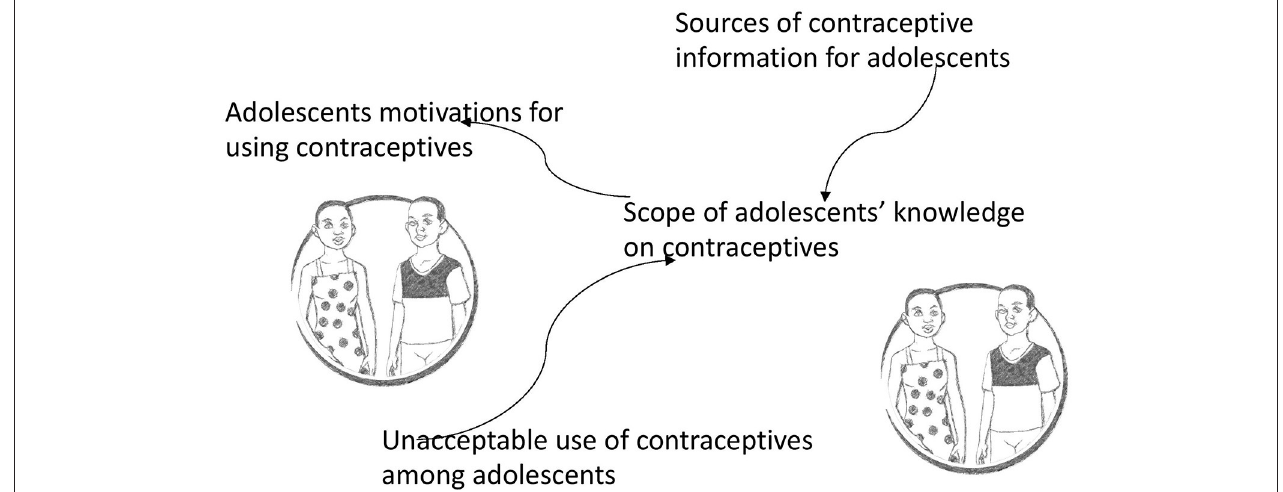
FIGURE 1 | The framing of motivations of adolescents and young people for contraceptive